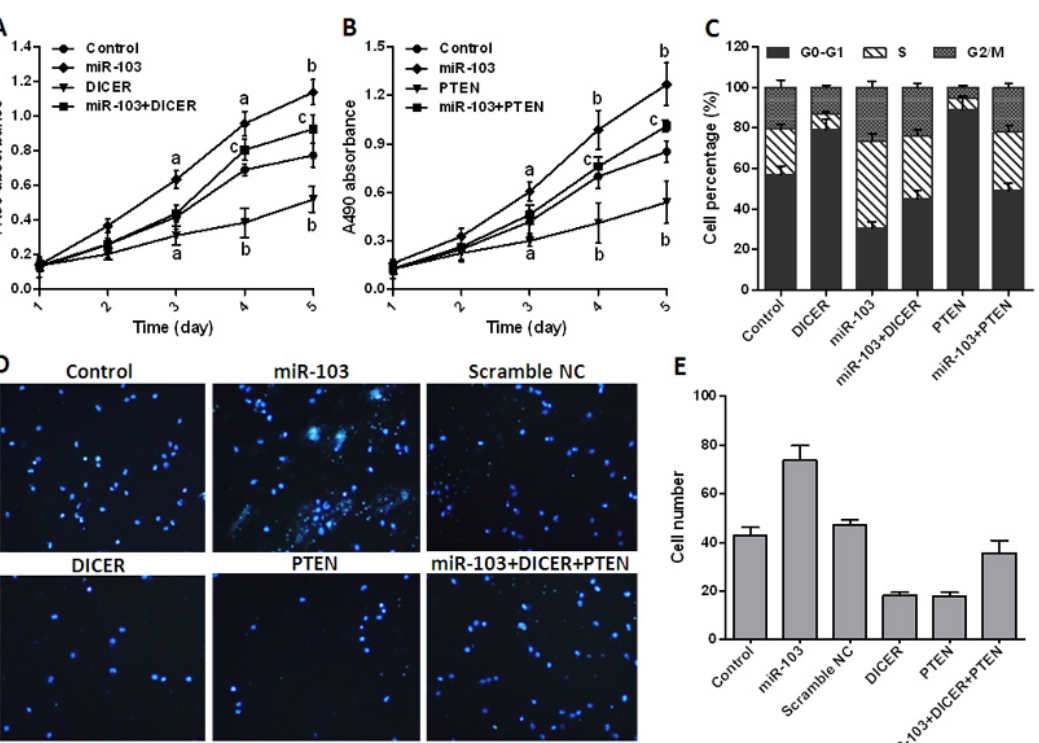
Figure 5. miR-103 promotes colorectal cancer cell proliferation and cell cycle by targeting DICER and PTEN . ( A , B ) 3-(4,5-Dimethylthiazol-2-yl)-2,5-diphenyltetrazolium bromide (MTT) assay was used to check the proliferation rates of transfected HCT-116 cells; ( C ) Cell cycle distributions of transfected HCT-116 were analyzed by flow cytometry; ( D ) Transwell assay was used to detect cell migration (40× magnification); and ( E ) analysis results of D . Data are representative of three experiments. Error bars represent as mean ± SD. a p < 0.05; b p < 0.01 vs. control; c p < 0.05 vs. miR-103 transfection